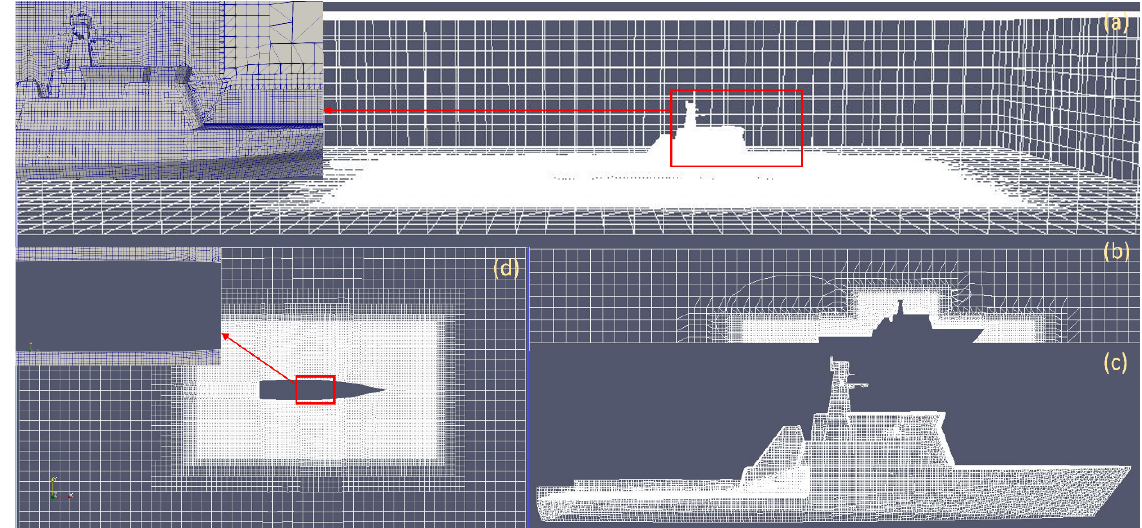
Figure 3. The mesh distribution around the above-water part of the hull for the headwind condition, where ( a ) is the top view of the domain, ( b ) is the side view at the centre of the mesh, ( c ) is the mesh distribution on the ship hull, and ( d ) is the mesh distribution at the bottom plane.